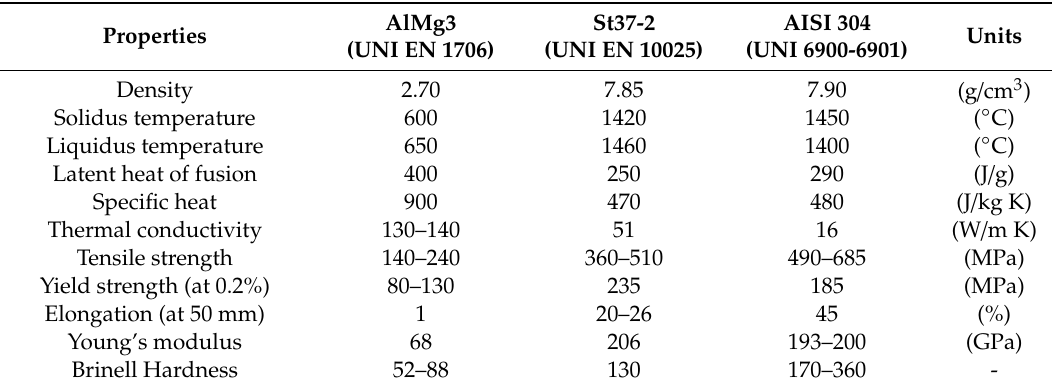
Table 2. Main properties of the adopted